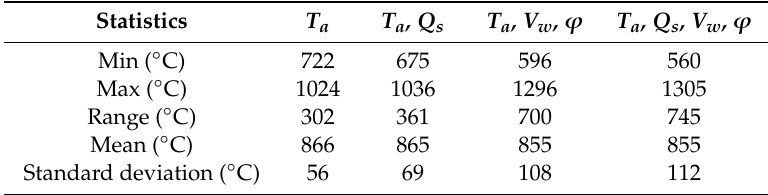
Table 2. Statistics of ampacity due to variation in weather parameter combinations.